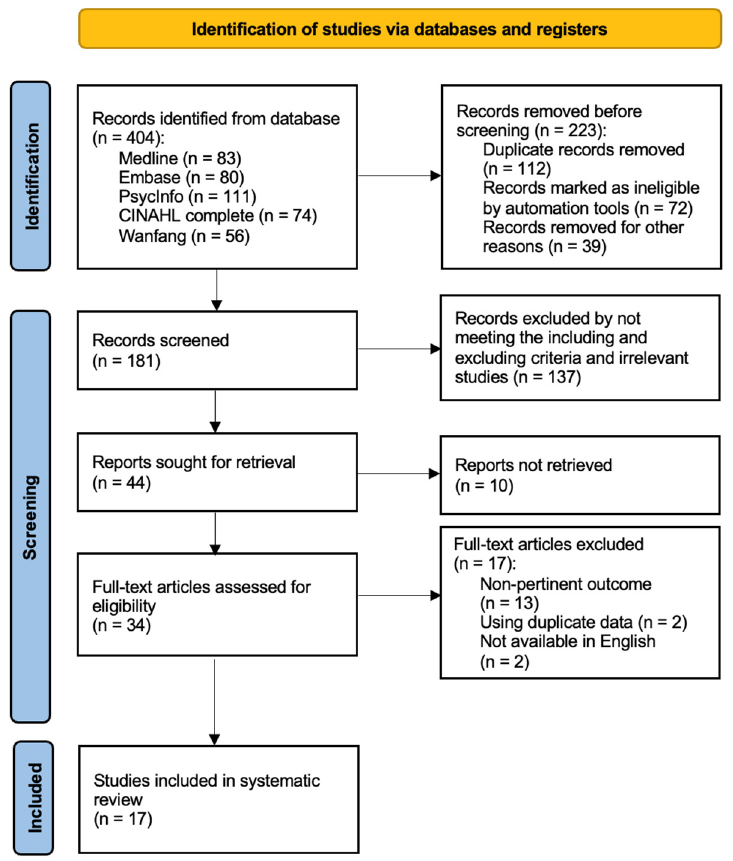
Figure 1. PRISMA flow chart of the article selection process.